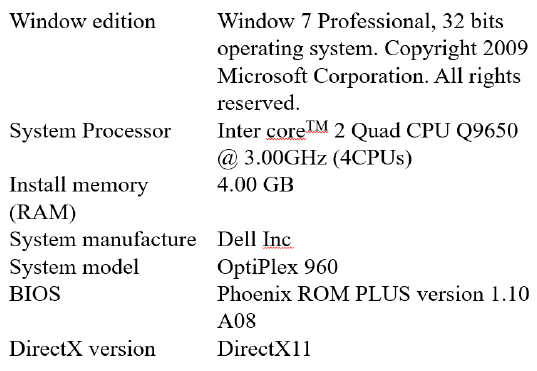
Figure 4. Computer configuration for running the optimization controller (OC).